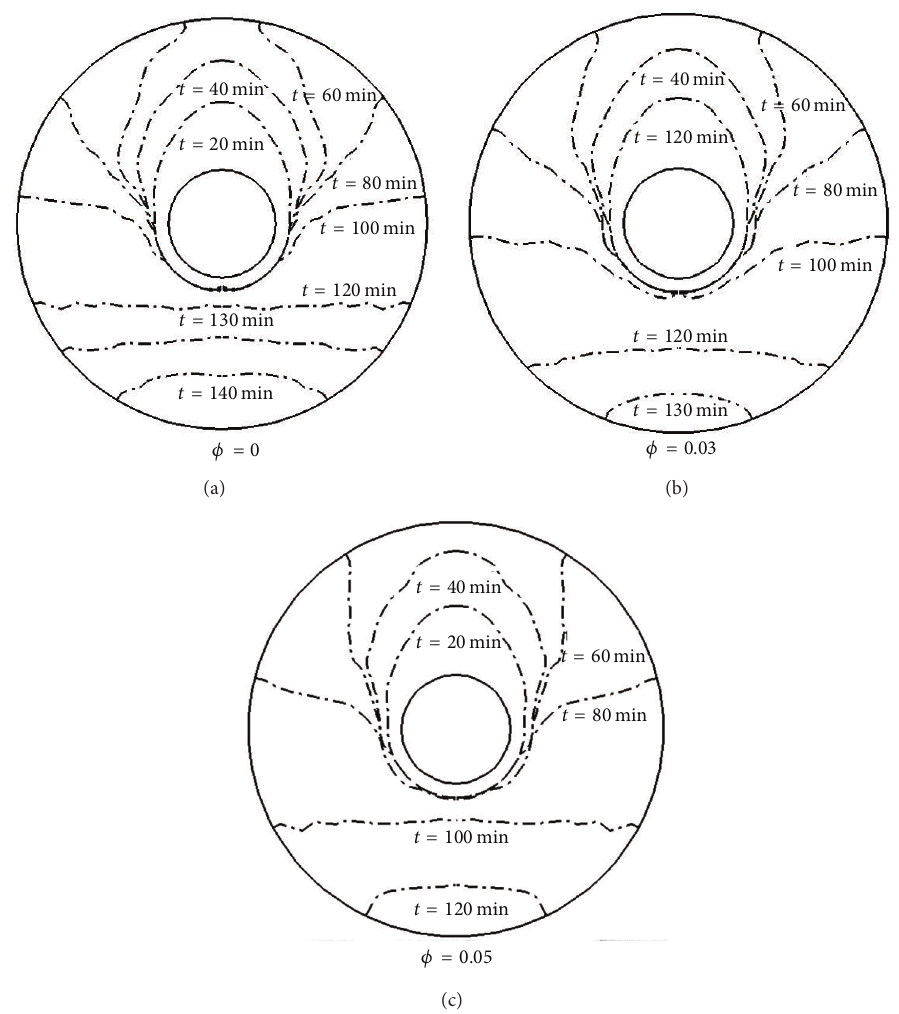
Figure 5: The phase interface position at various moments for various volume fractions of nanoparticle.